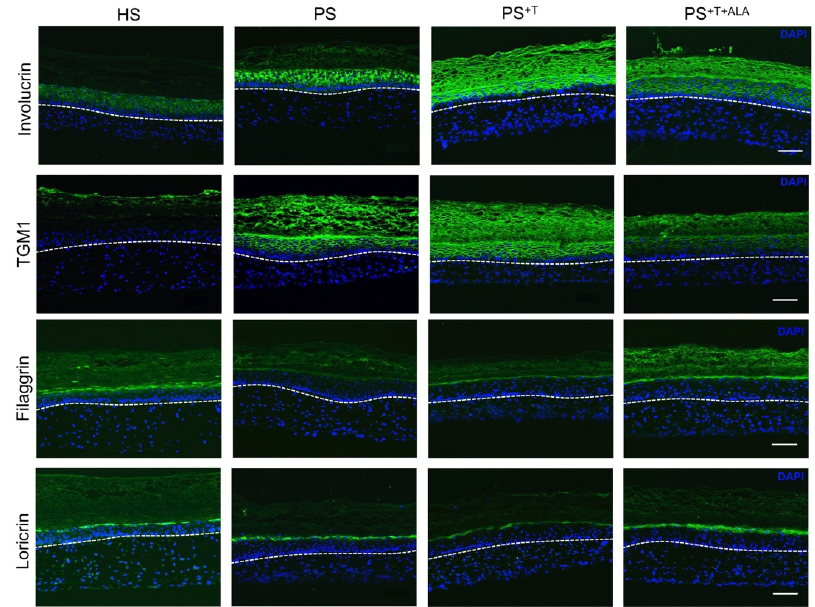
Figure 2. Immunofluorescence staining of cell differentiation proteins in skin substitutes. Indirect immunofluorescence staining was carried out on HS, PS, PS +T and PS +T+ALA . Nuclei were counterstained with DAPI reagent (blue). Dashed white lines represent the basement membrane. Scale bar: 100 μ m. Abbreviations: ALA: alpha-linolenic acid; HS: healthy substitutes; T: T cells; PS: psoriatic substitutes; PS +T : psoriatic substitutes produced with T cells; PS +T+ALA : psoriatic substitutes produced with T cells and supplemented with ALA; TGM1: transglutaminase